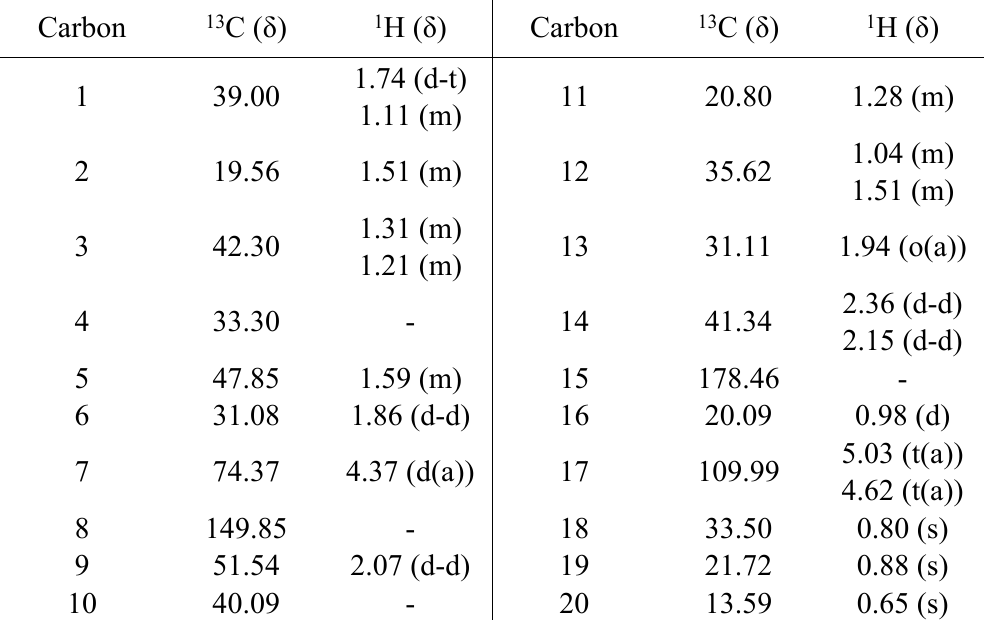
Table 1 . 13 C- and 1 H-NMR assignment of salvic acid ( 1